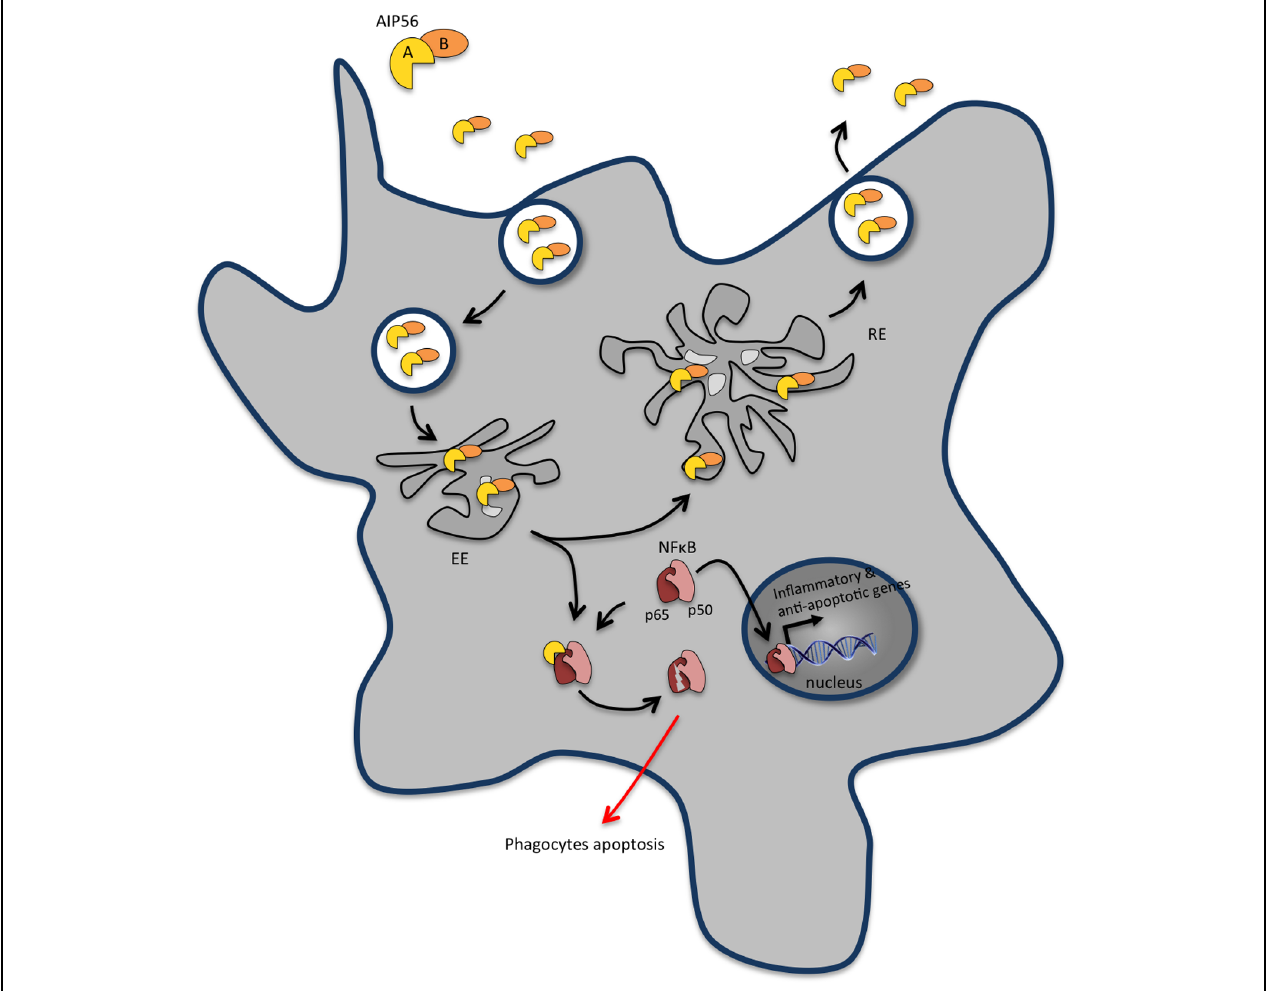
FIGURE 3 | AIP56 blocks innate immunity by inducing massive apoptosis of host macrophages and neutrophils. Upon encountering susceptible cells, apoptosis-inducing protein of 56 kDa (AIP56) binds to a still unidentified cell-surface receptor and undergoes clathrin-mediated endocytosis. Once in early endosomes, the toxin either follows the recycling pathway back to the extracellular medium or suffers low pH-induced translocation across the endosomal membrane into the cytosol to display its toxic activity. AIP56 is a zinc-dependent metalloprotease that cleaves the p65 subunit of nuclear factor- κ B (NF- κ B), an evolutionarily conserved transcription factor that regulates the expression of inflammatory and anti-apoptotic genes and plays a key role in host responses to microbial pathogen invasion. During infection, AIP56 disseminates systemically and its activity leads to depletion of macrophages and neutrophils by post-apoptotic secondary necrosis, thereby blocking the phagocytic defense of the host and contributing to the occurrence of tissue